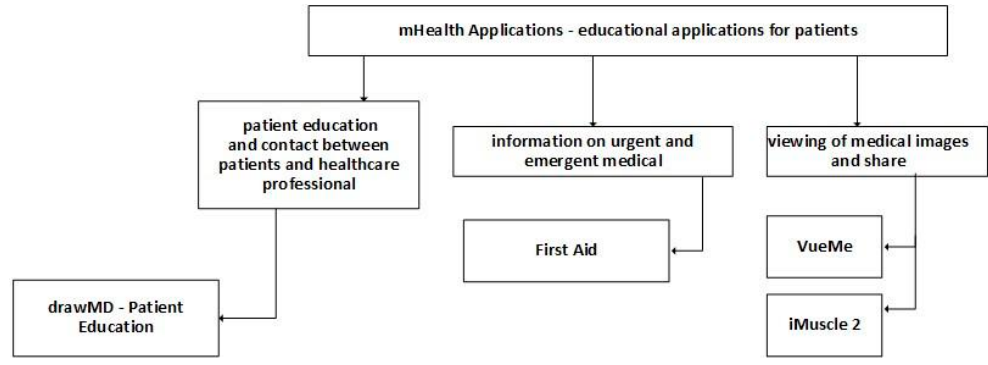
Figure 3. Classification of mobile health applications related to patient education.